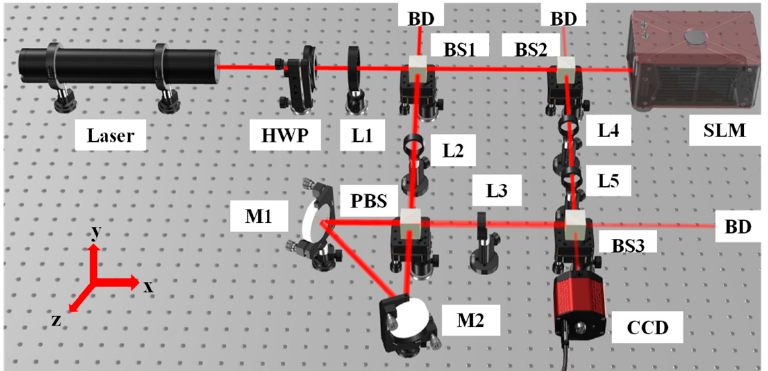
Figure 2. Schematic of the polarization interferometer for Jones matrix imaging of SLM. HWP: half-wave plate, Ln ( n = 1 to 5): lenses, SLM: spatial light modulator, BSn ( n = 1 to 3): non-polarizing beam splitter, PBS: polarizing beam splitter, Mn ( n = 1, 2): mirrors, CCD: charge-coupled device, BD: beam dump.